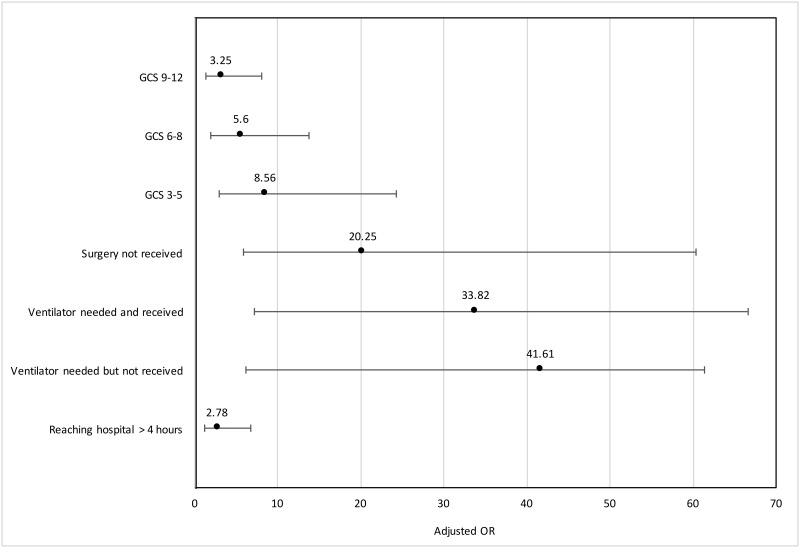
Multivariate model of predictors of traumatic brain injury mortality by adjusted odds ratios (OR).This parsimonious multivariate model was generated through logistic regression using the stepwise backward elimination approach at the p<0.05 level. The model was adjusted for the following confounders: age, polytrauma, and CT diagnosis.